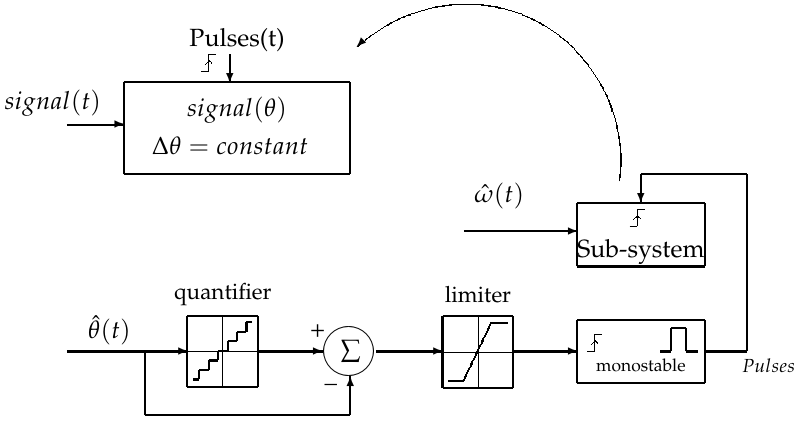
Figure 5. Block diagram of the online re-sampling.